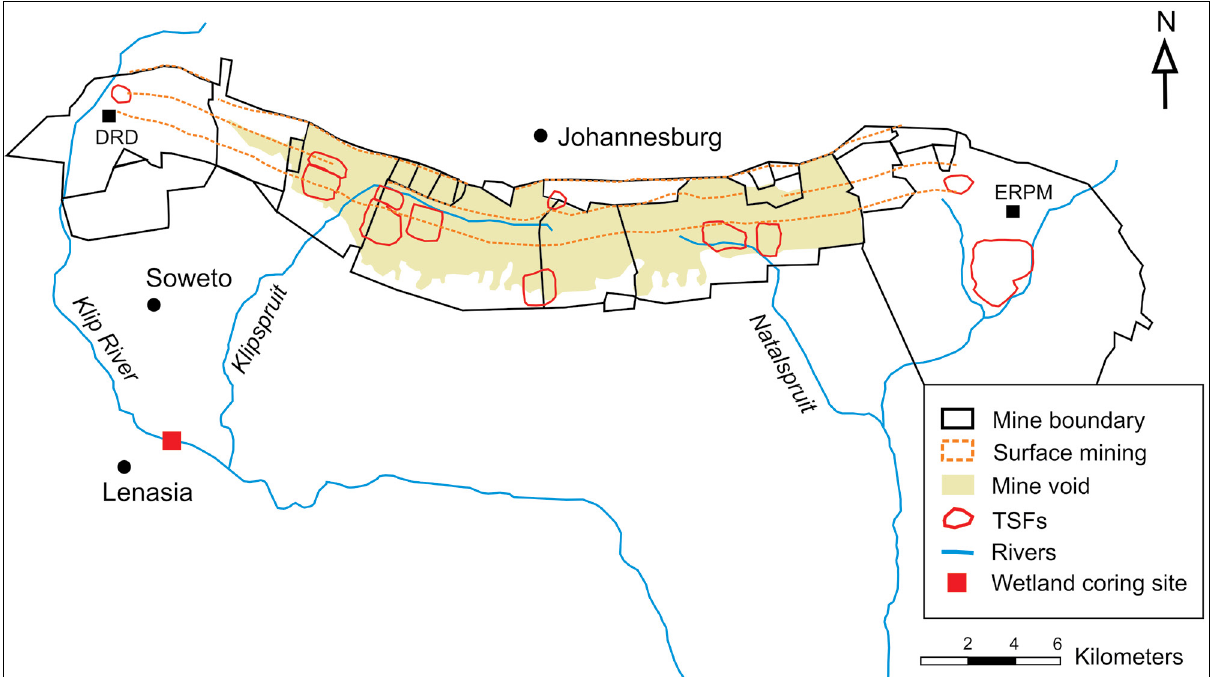
Figure 6: Map showing the extent of mining activities and areas of major water ingress into the Central Basin mine void. 23